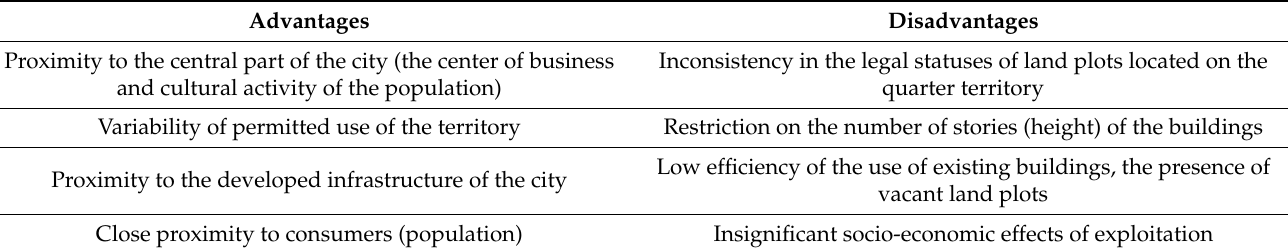
Table 4. Advantages and disadvantages of the study